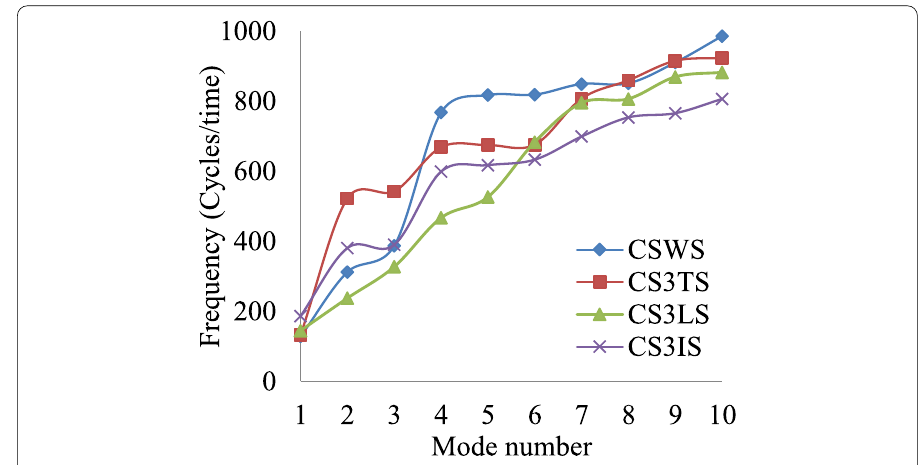
Fig. 9 Comparison of frequencies of the plates with three stiffeners